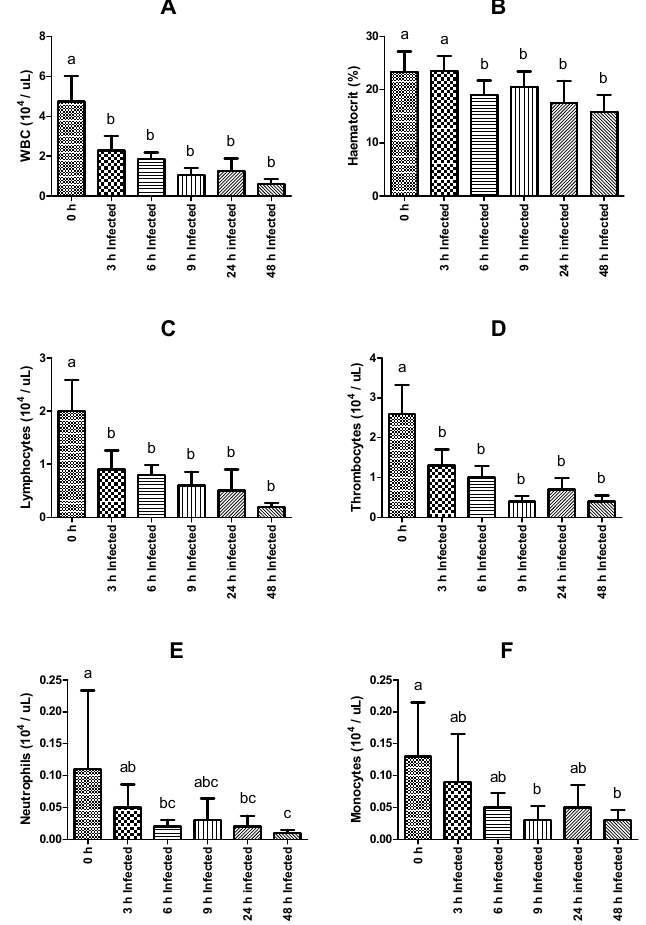
Figure 1. Hematological parameters of rainbow trout sampled before (0 h) or 3, 6, 9, 24, and 48 h post-intraperitoneal infection with Y. ruckeri (means ± SD, n = 6). ( A ) WBC (white blood cells); ( B ) Hematocrit; ( C ) Lymphocytes; ( D ) Thrombocytes; ( E ) Neutrophils; ( F ) Monocytes. Letters indicate significant differences between the bio-groups ( p ≤